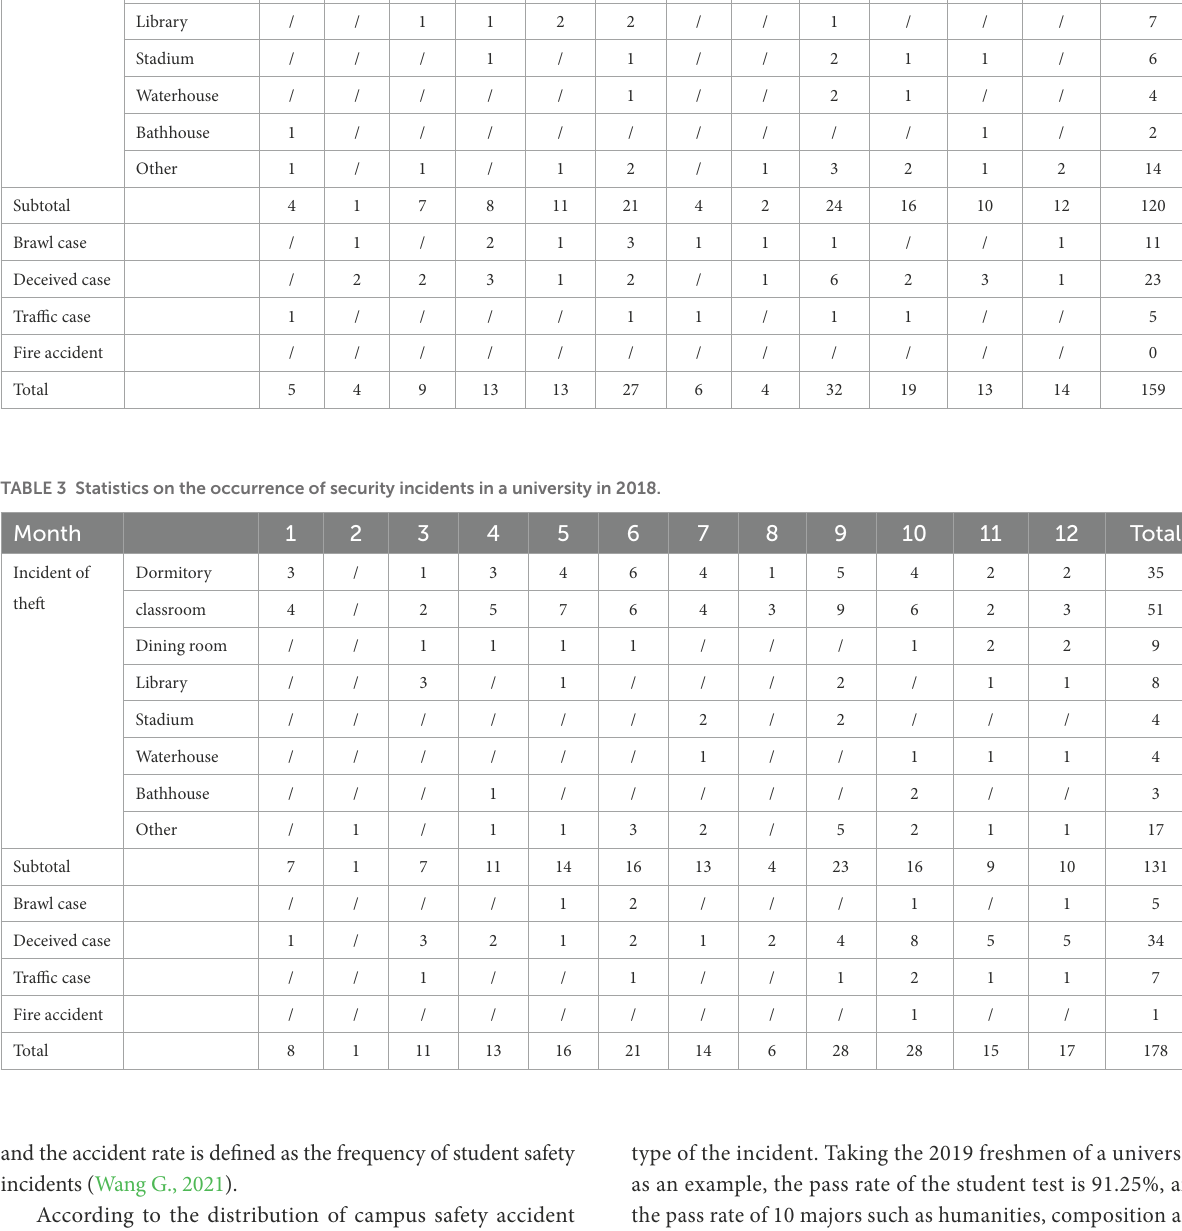
TABLE 2 Statistics on the occurrence of security incidents in a university in 2017. Month Incident of theft